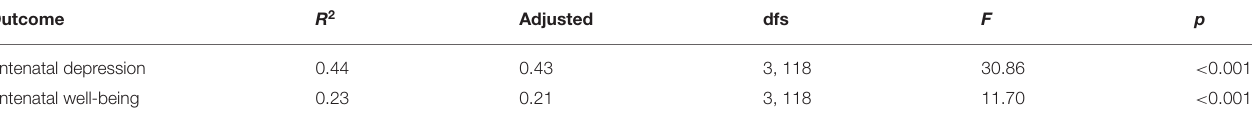
TABLE 3 | Model parameters for antenatal depression and